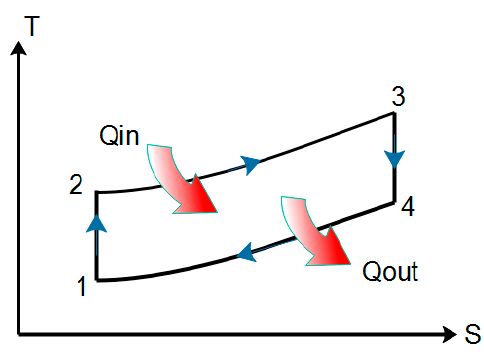
Figure 2. Temperature–Entropy (or T–S) diagram.